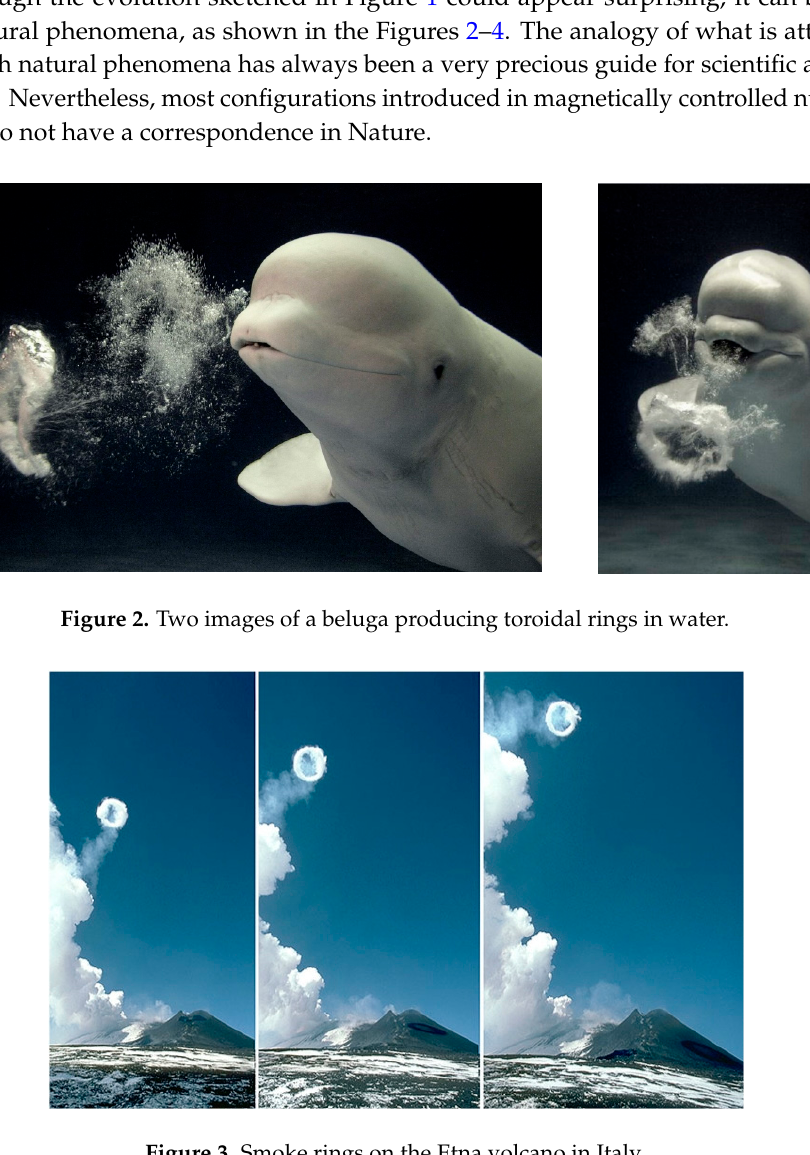
Figure 4. Comparison between the Hopf foliation ( left ) and a combined X ‐ rays and infrared image of the Crab Nebula after a supernova explosion ( right ).